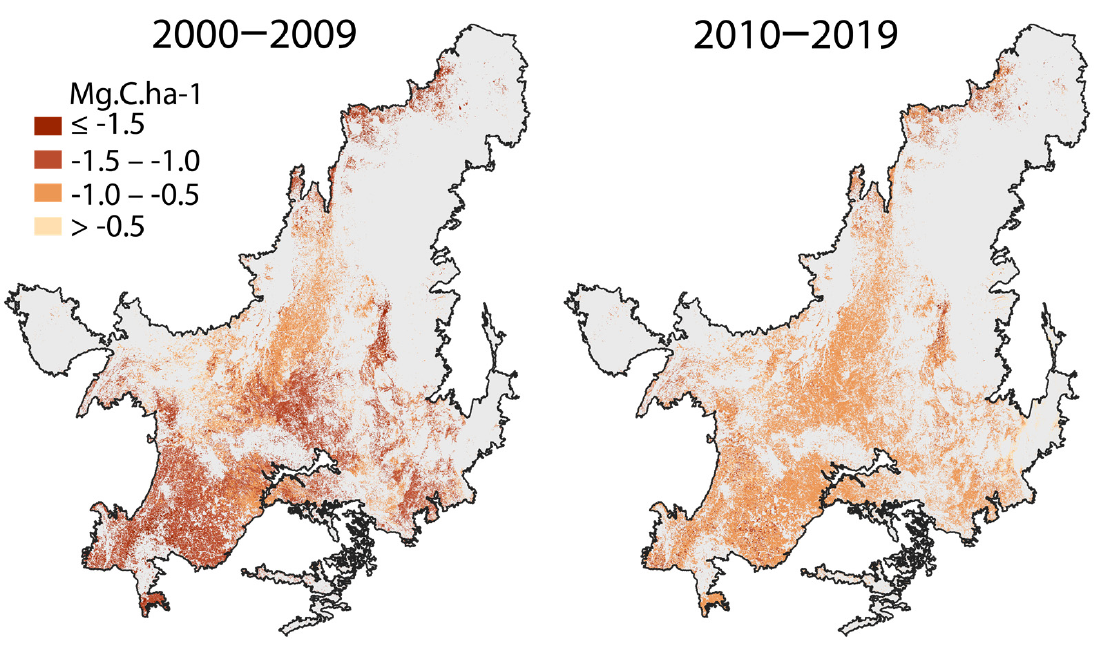
Figure 7. Changes in soil carbon stocks in pastures in the Brazilian Savanna (the Cerrado) in two periods: ( i ) 2000 to 2009 and ( ii ) 2010 to 2019.